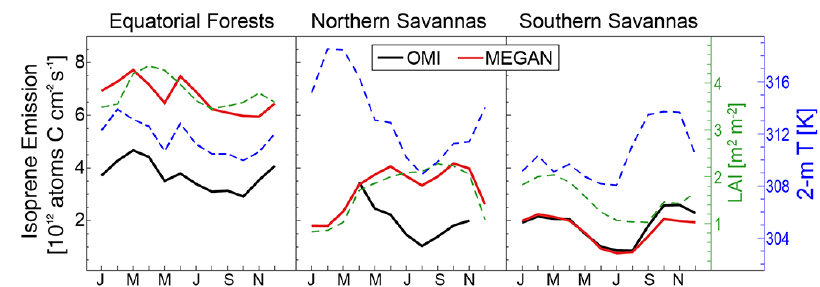
Figure 4. Seasonality of isoprene emissions and environmental variables averaged over the coherent African regions of Fig. 3. Monthly mean OMI-derived (black) and MEGAN (red) isoprene emissions are shown together with GEOS-5 2m temperature (blue) and MODIS LAI (green). OMI-derived isoprene emissions are not available for northern savannas in December–March because of biomass burning interference. Emissions and 2m temperature are for 12:00–15:00 LT. LAI is the combined Terra and Aqua product (Yang et al., 2006). All data are means for 2005–2009. Table 1b. Leaf-level isoprene flux measurements in Africa a